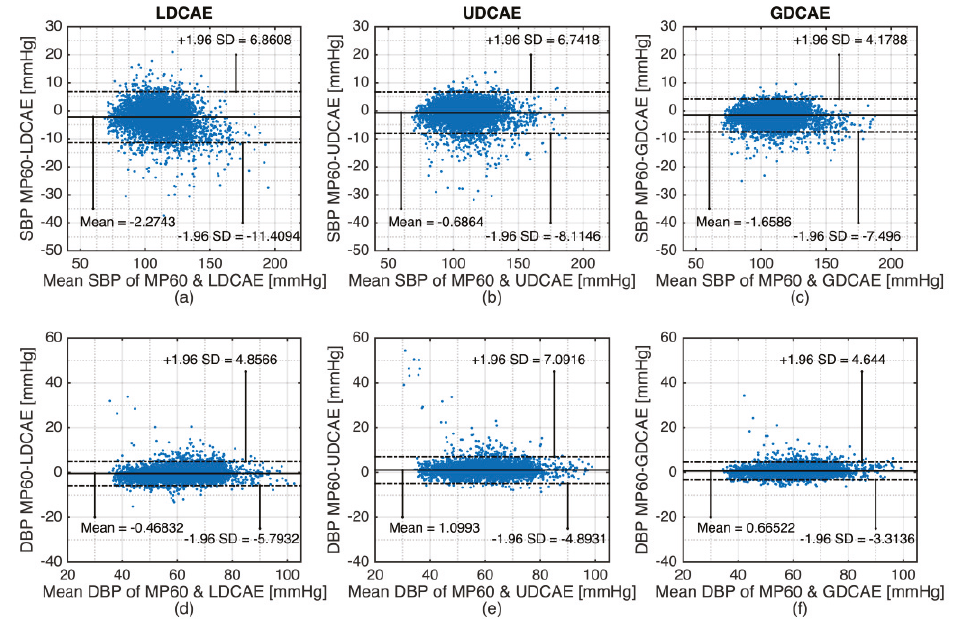
Figure 7. Bland–Altman plot. a ) LDCAE systolic blood pressure (SBP); b ) UDCAE SBP; c ) GDCAE SBP; d ) LDCAE diastolic blood pressure (DBP); e ) UDCAE DBP; f ) GDCAE